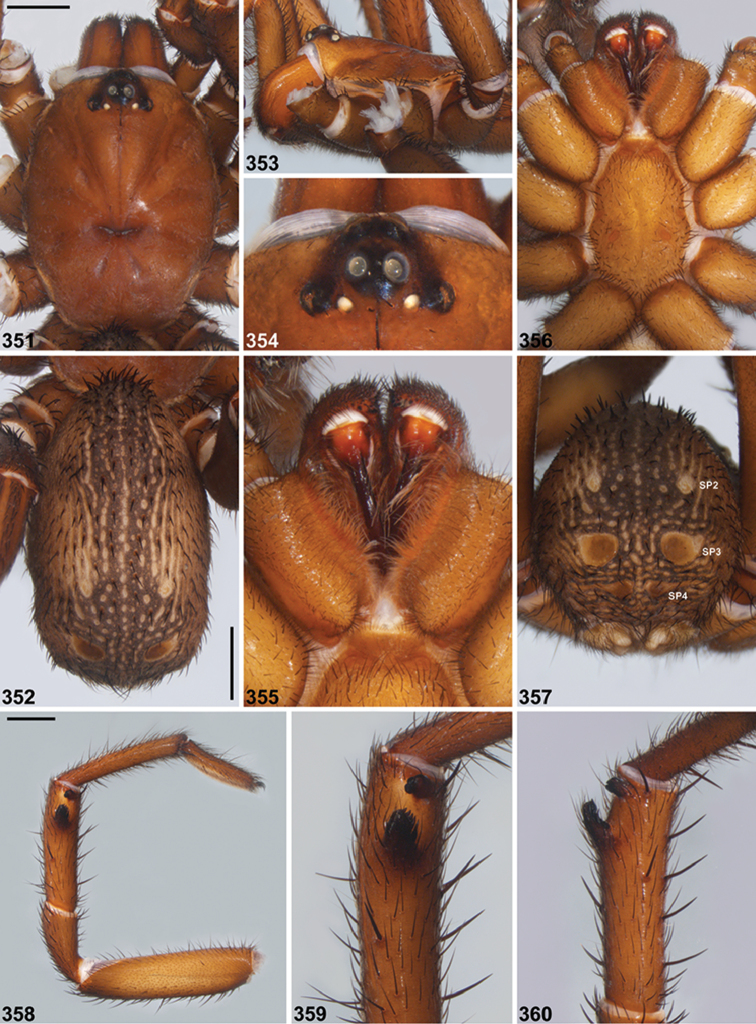

Idiosoma
sigillatum (O.P.-Cambridge, 1870), male (WAM T139480) from Duncraig, Perth (Western Australia; SWA), somatic morphology. 351–352 Carapace and abdomen, dorsal view 353 Carapace, lateral view 354 Eyes, dorsal view 355 Mouthparts, ventral view 356 Sternum, ventral view 357 Abdomen, posterior view 358 Leg I, prolateral view 359 Leg I tibia, clasping spurs, prolateral view 360 Leg I tibia, proventral view. Scale bars 2.0. SP2–4 = sigilla pairs 2–4.